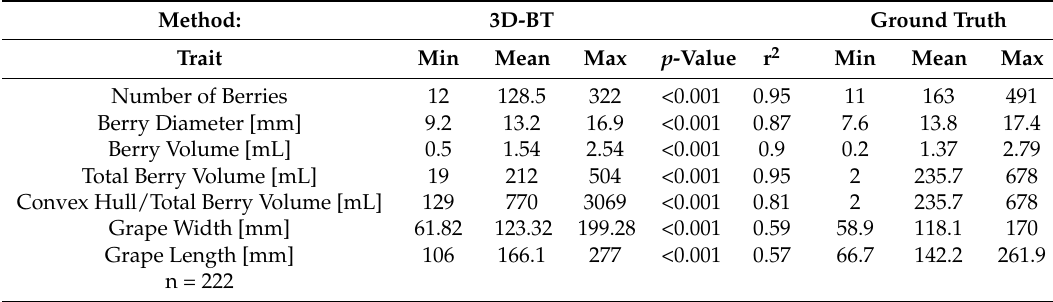
Table 2. Correlation Coefficient with related p -values and min, mean, max values for bunch parameters of genotypes from the cross population GF.GA-47-42 × “Villard